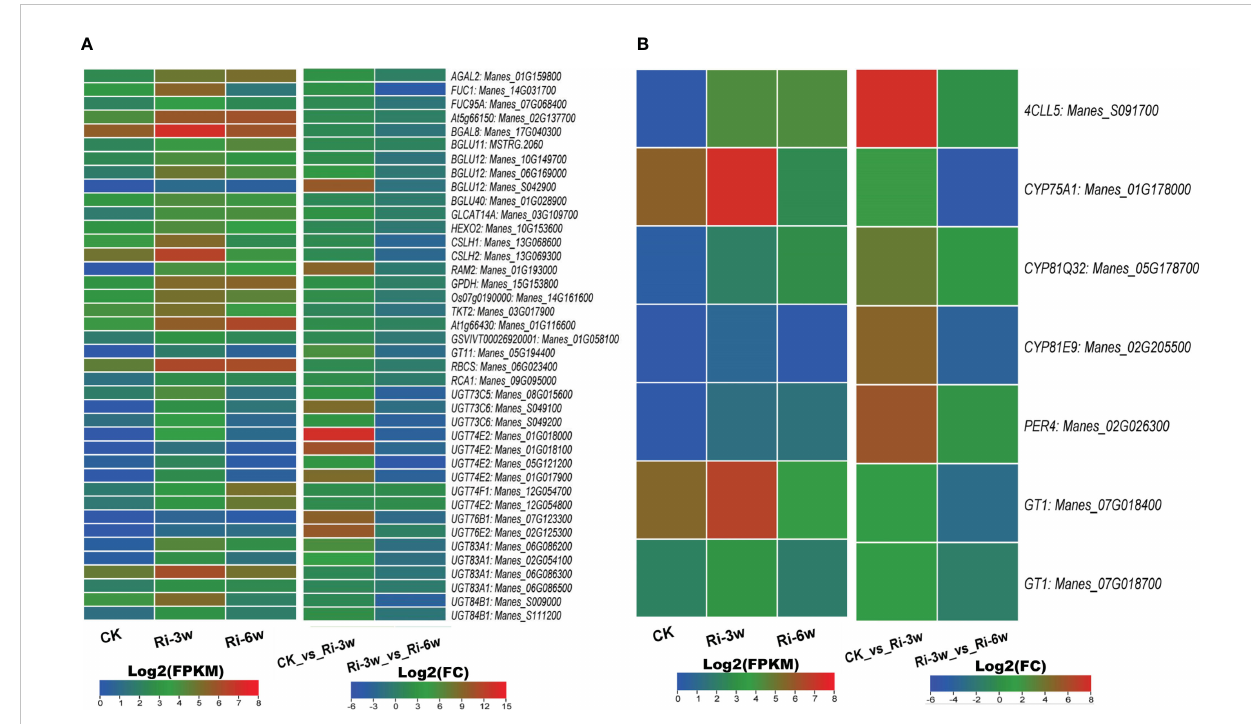
FIGURE 6 Transcription levels of DEGs related to sugar metabolism (A) and phenylpropanoid pathway (B) . FPKM, Fragments Per Kilobase of transcript per Million mapped reads. Genes ’ annotation is presented in Tables S9C,